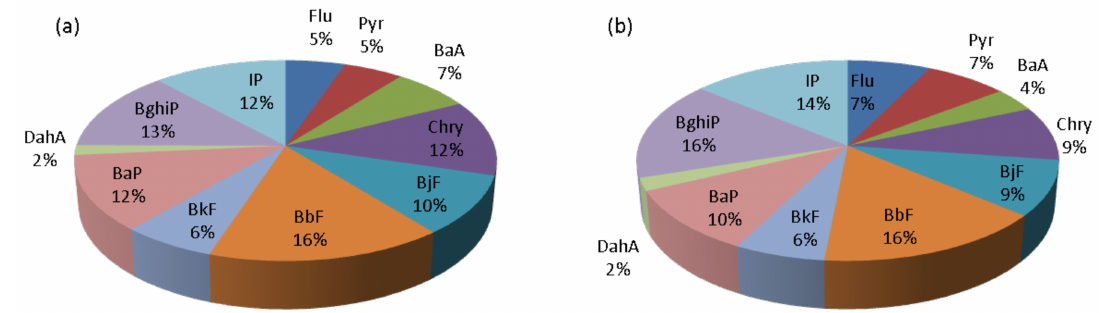
Figure 5. The contributions of the individual PAHs to the sum of total PAH mass concentration during: ( a ) cold and ( b ) warm